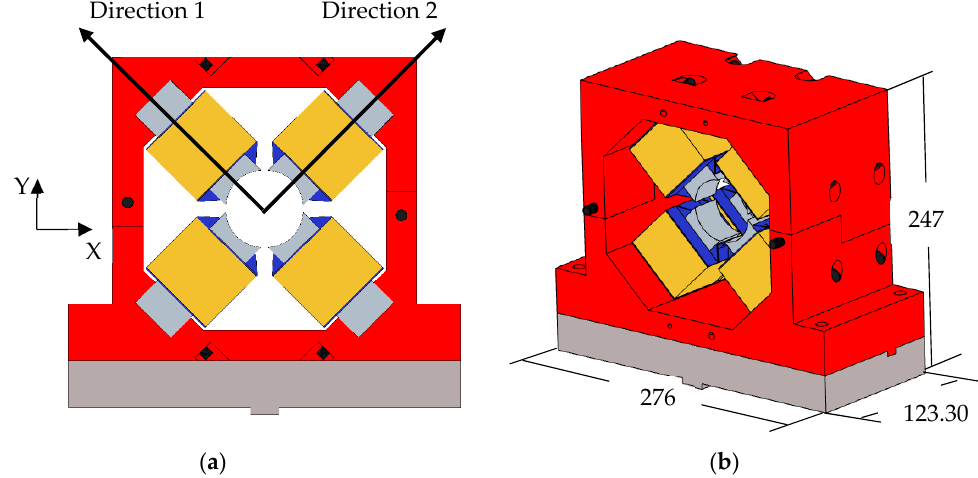
Figure 4. ( a ) Core directions rotated by 45° for applying excitation load; ( b ) main dimensions of the magnetic actuator.